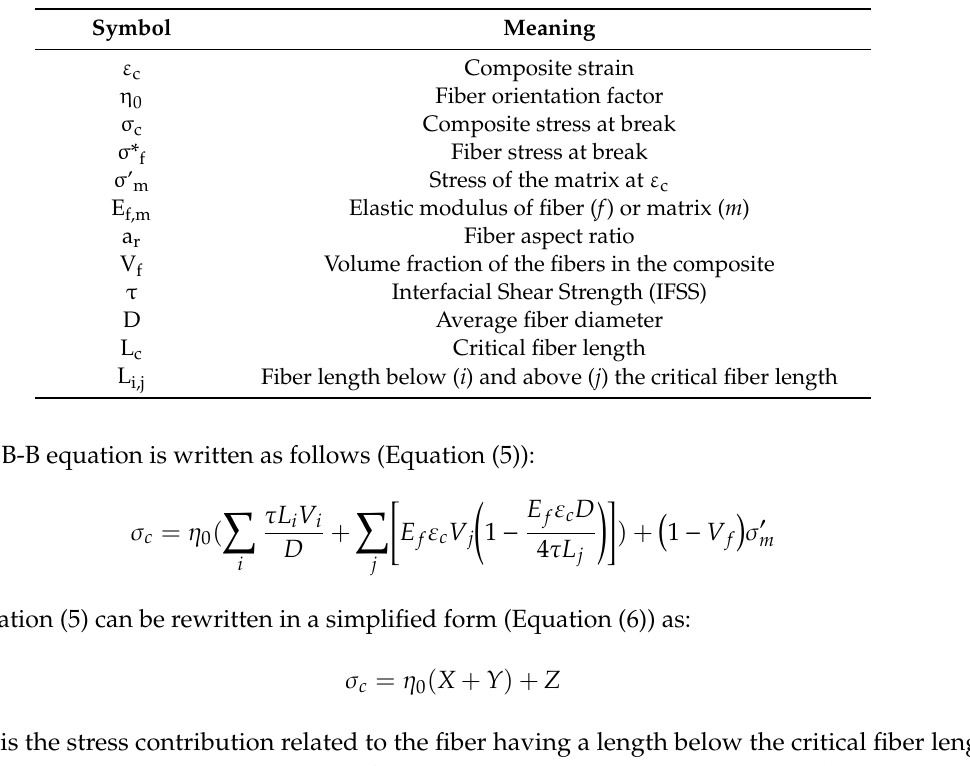
Table 3. Bader and Bowyer model